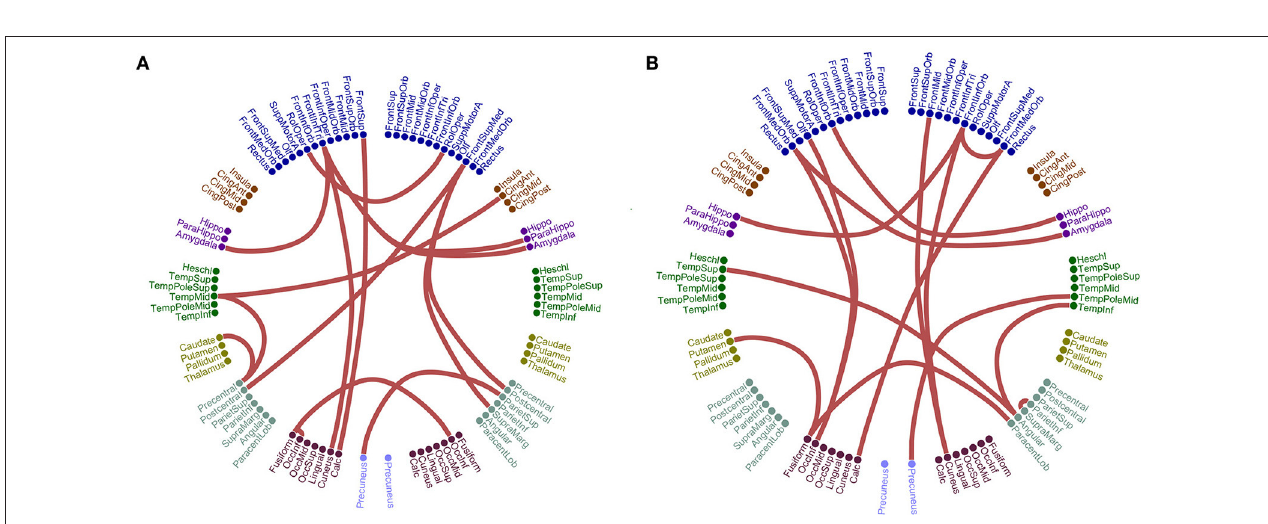
FIGURE 5 | Network topology of the selected edge-weighted features using the CorrEnv connectivity estimator for β 1 : β 2 and α 1 : α 2 . The two network topologies differ on their ROI representation approach. (A) PCA ROI representation for β 1 : β 2. (B) Centroid ROI representation for α 1 : α 2 . The 90 ROI are illustrated circularly with 45 per hemisphere (left – right semi-circular